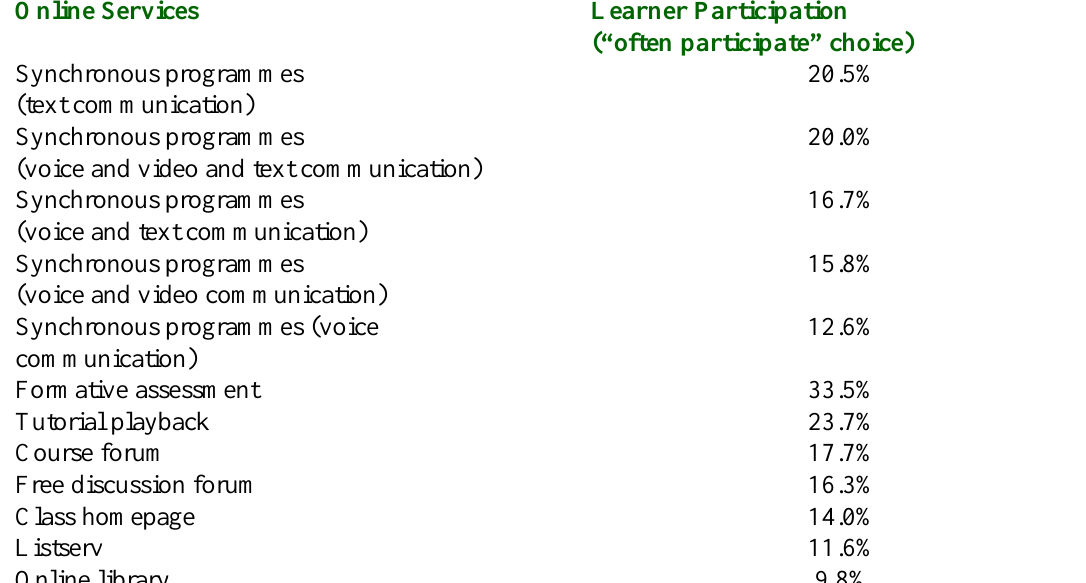
Table 6. Learners’ ratings of online learner support services Online